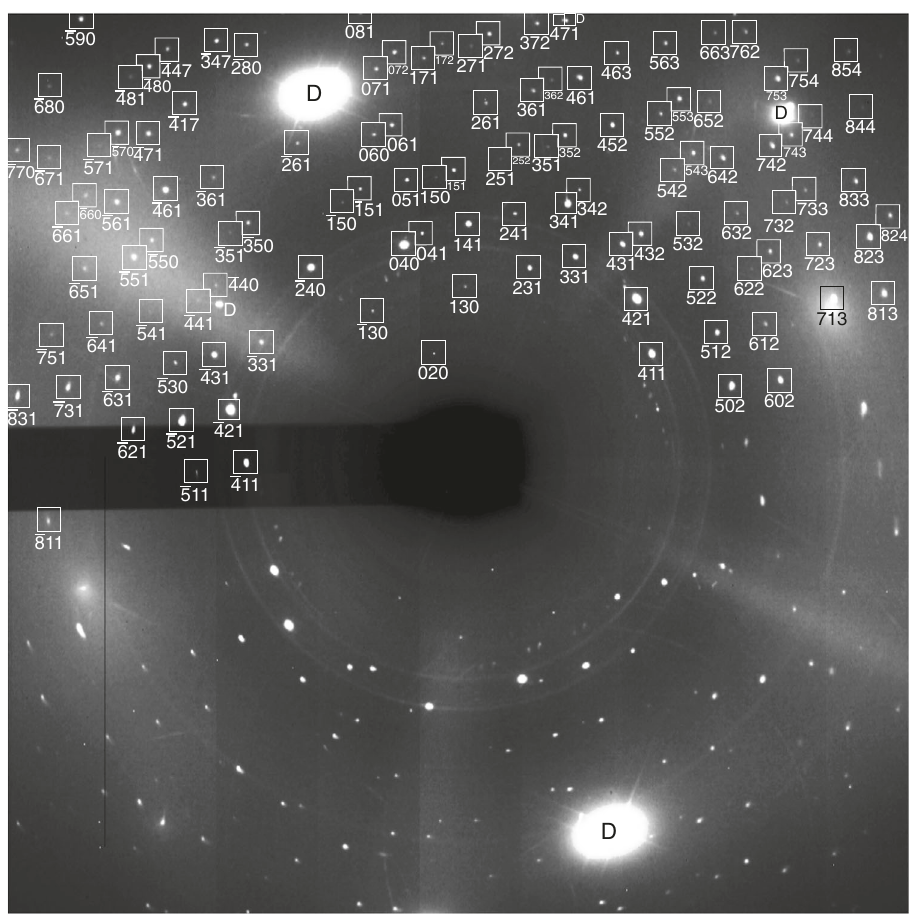
Fig. 2 Single crystal X-ray diffraction pattern of ι – N 2 at 56 GPa. The data were collected over a 56° scan range upon quenching the sample to ambient temperature. Squares mark nitrogen re fl ections with the given hkl indices. Diamond re fl ections are labelled with the letter D . Indices are not shown on the lower half of the image plate to clearly display the quality of the raw